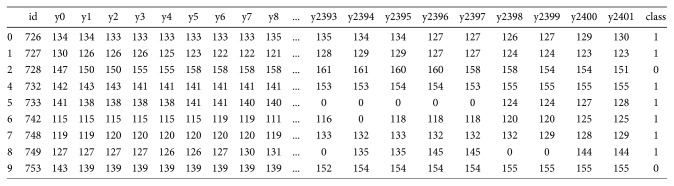
Time series data.